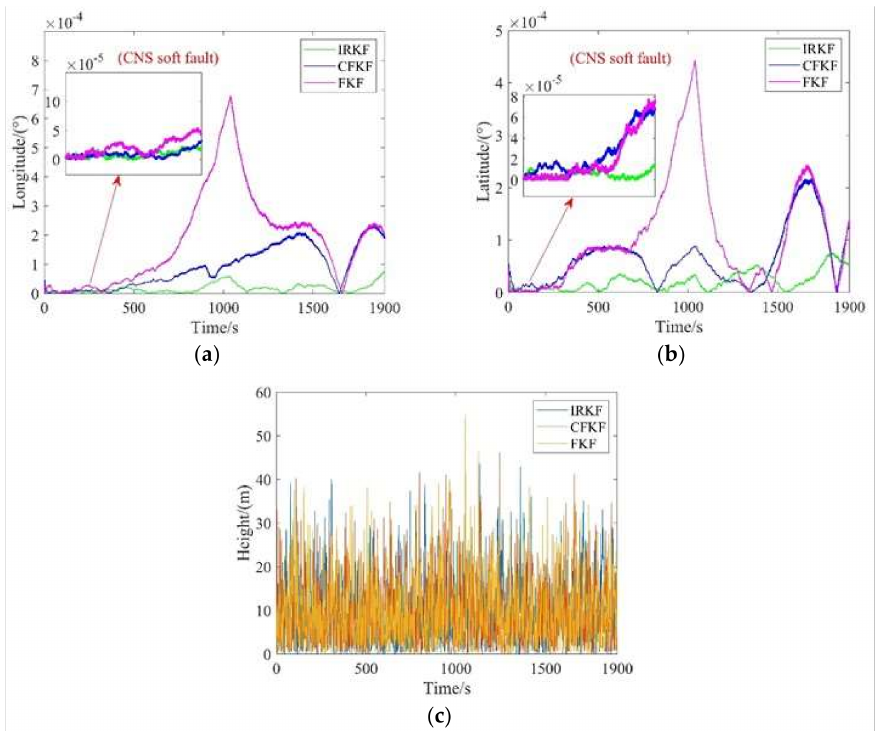
Figure 10. Estimation error of position. ( a ) Estimation error of longitude. ( b ) Estimation error of latitude. ( c ) Estimation error of